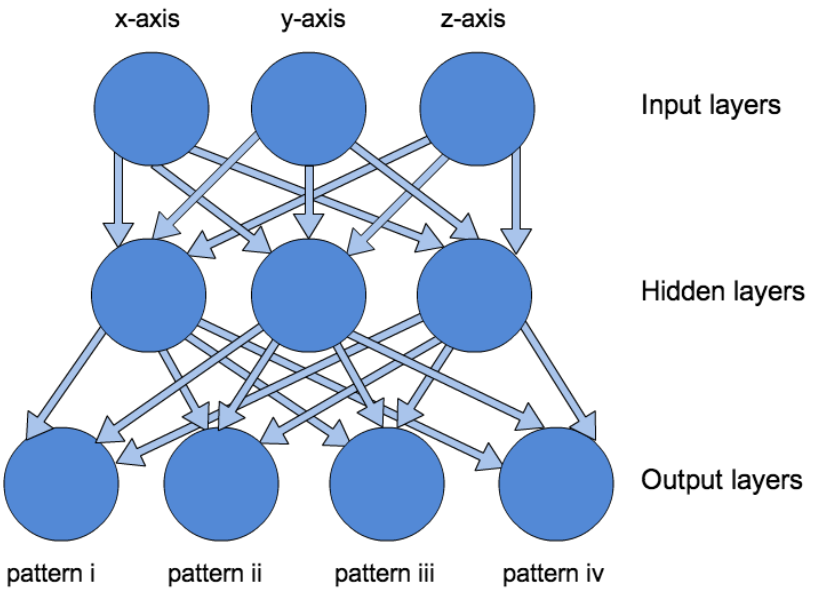
Figure 5. Structure of the employed Multi-layered Perceptron